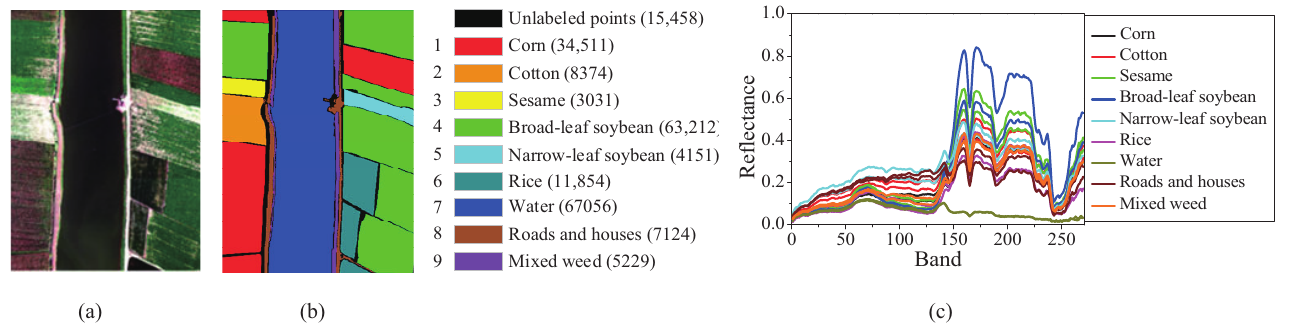
Figure 3. LongKou hyperspectral image. ( a ) False color image. ( b ) Ground truth. ( c ) Spectral curves. (Note that the number of samples for each class is shown in